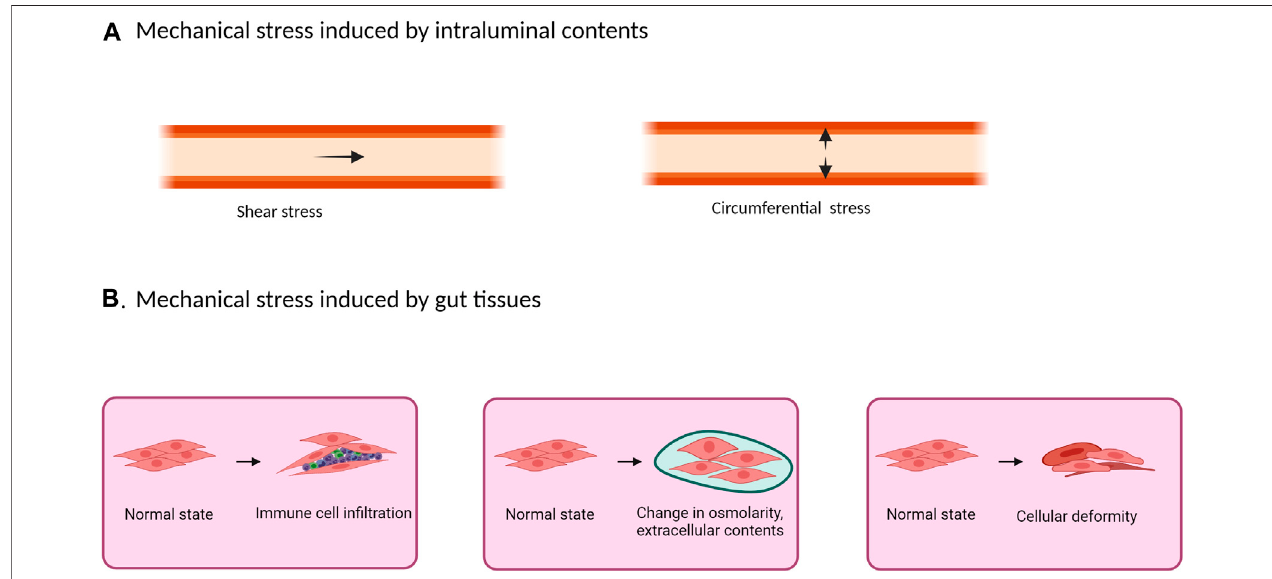
FIGURE 1 | Mechanical stress in the gut may originate from the intraluminal contents (A) or from inside the tissues (B) . (A) The presence and movement of intraluminal contents create shear stress and intraluminal pressure. While shear stress is a transient force generated at the mucosa surface tangential to the GI tract, intraluminalpressurecreatesacircumferentialmechanicalstretchperpendiculartothegutwall. (B) Physicalstretchandcompressionalsoexistinsidethegastrointestinal tissues in pathological conditions such as in in fl ammation with in fl ammatory cell in fi ltrations, edema, extracellular matrix deposition, and deformation.